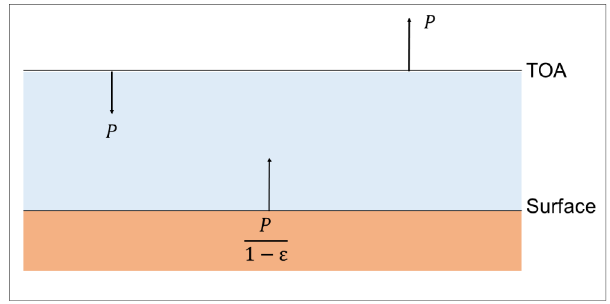
Figure 1. Surface amplification of absorbed solar insolation P . ε , 0 ≤ ε < 1 is the bulk emissivity of the atmosphere with respect to the surface radiation. Units W/m 2 . TOA = top of atmosphere.